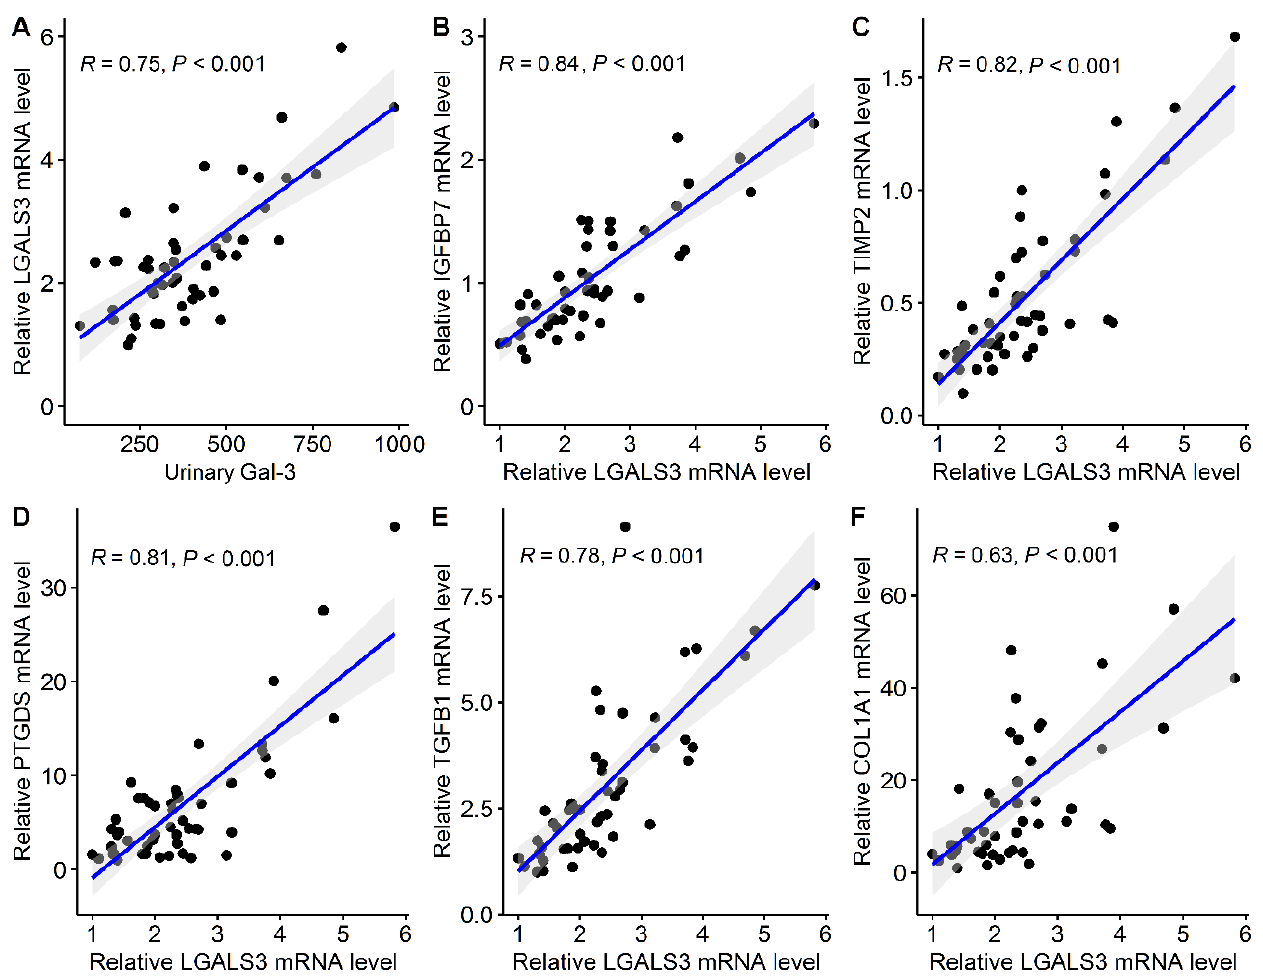
Figure 3. Correlation plots of ( A ) urinary Gal-3 and intrarenal LGALS3 as well as LGALS3 with ( B ) IGFBP7, ( C ) TIMP2, ( D ) PTGDS, ( E ) TGFB1 and ( F ) COL1A1 in kidney biopsy specimens.